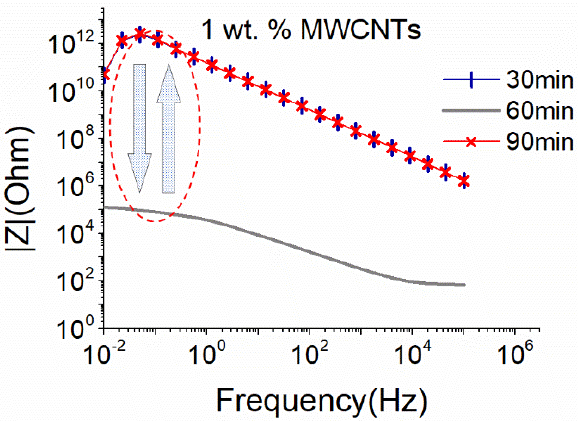
Figure 2. EIS plots of aqueous dispersion with 1 wt.% MWCNTs using the big sonication probe at an amplitude of 25% (18.6 W).